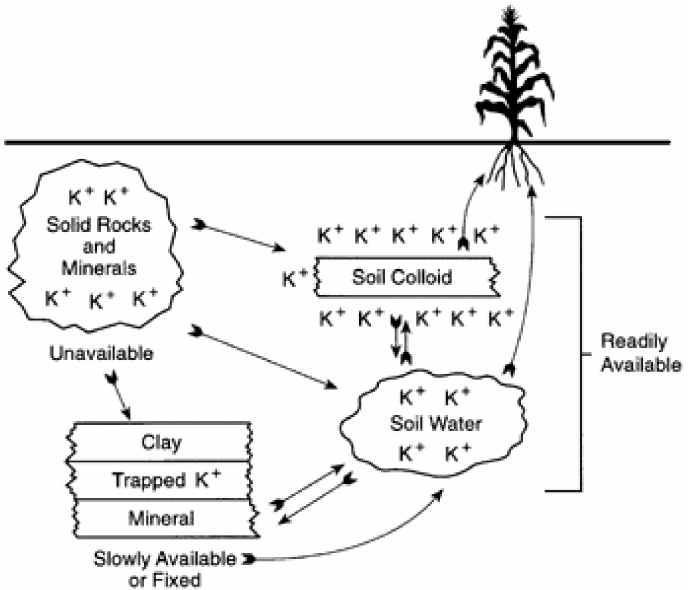
Figure 3. Relationship among different form of potassium in the soil-plant system